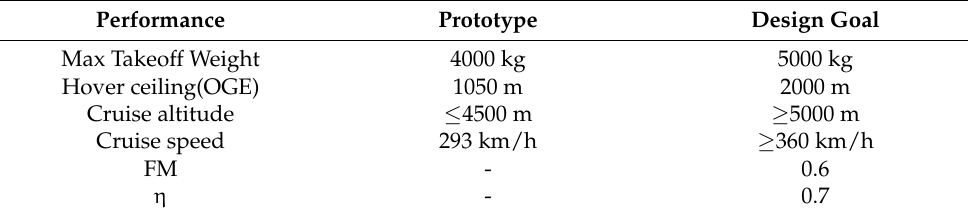
Figure 9. Z ‐ 9 helicopter prototype. Table 2. Flight performance of prototype and design goal. Table 2. Flight performance of prototype and design goal.